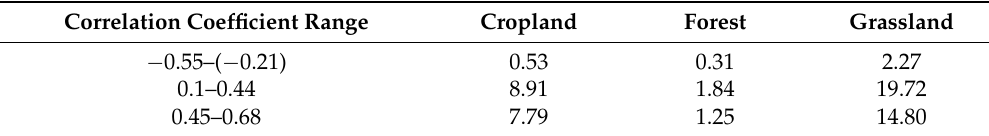
Table 3. Percentage of the area in each land cover class with Normalized Difference Vegetation Index (NDVI)/Soil Moisture correlation.